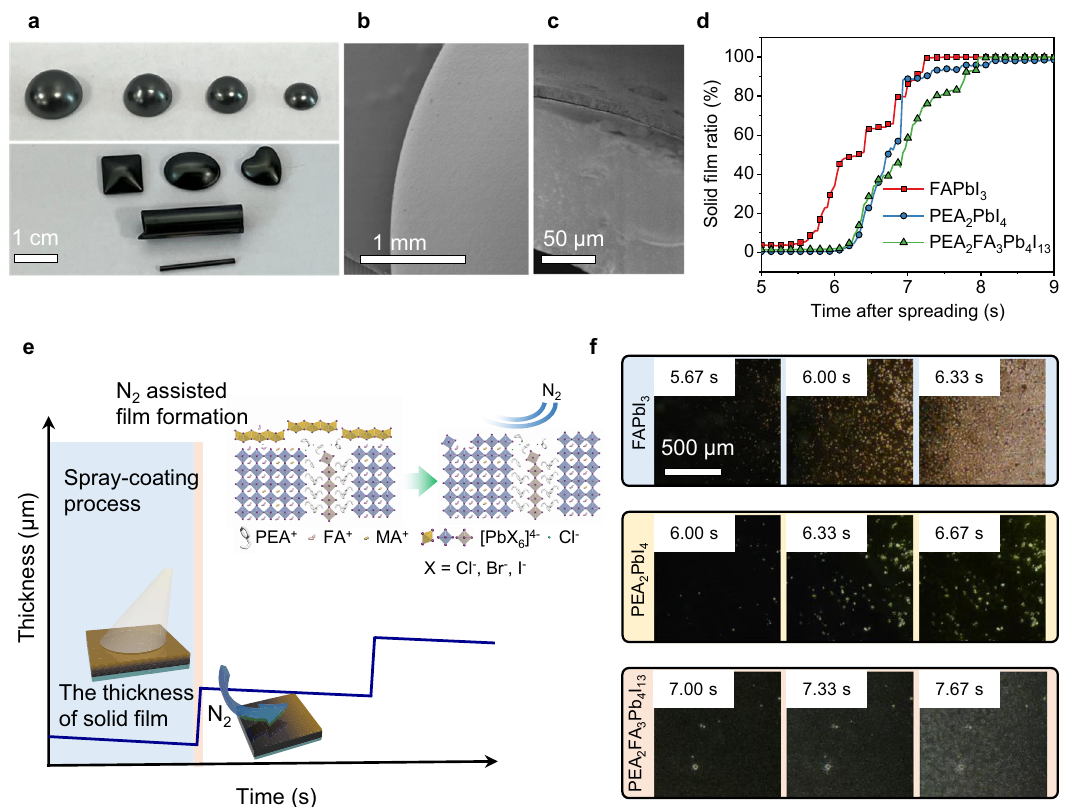
Fig.2|Thethickperovskite fi lmfabricatedbyspray-coatingandcrystallization process. a The optical photographs of spray-coated perovskite (PEA 2 FA 3 Pb 4 I 13 ) fi lms deposited onto different substrates of different sizes and shapes. b The SEM imageofthesurfaceoftheperovskite fi lmonhemisphericalsubstrate. c Thecross- sectionSEMimageoftheperovskite fi lmoncurvedsubstrate. d Thetimehistoryof